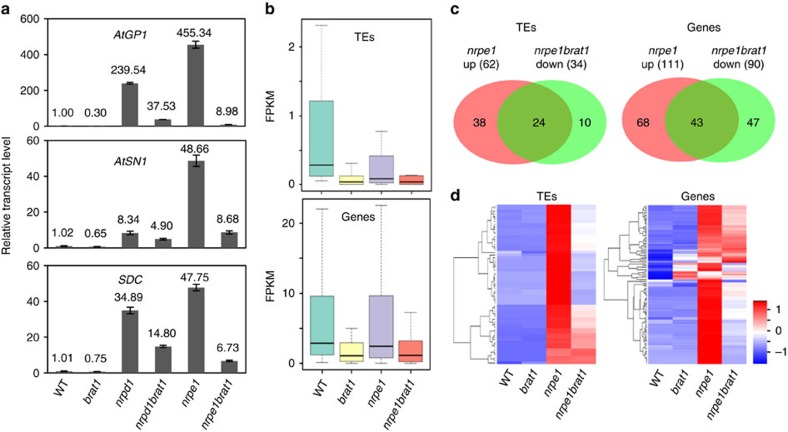
BRAT1 contributes to the expression of RdDM target loci in the RdDM mutants.(a) The RNA transcripts of AtGP1, AtSN1 and SDC were detected by quantitative RT–PCR in the indicated genotypes. Error bars are s.d. of three technical replicates in a representative experiment. (b) Box plots showing the expression of TEs and protein-coding genes that are downregulated in brat1. FPKM, fragments per kilo base of exons per million fragments mapped. (c) Venn diagrams of overlap between upregulated loci in nrpe1 versus wild type (WT) and downregulated loci in brat1nrpe1 versus nrpe1. (d) Heat maps showing RNA transcripts of upregulated (log2(fold-change of reads)>1, P<0.01,Cufflinks) TEs and genes in nrpe1 compared with the WT. The columns represent the indicated genotypes, and the rows represent the relative RNA transcript levels. Blue indicates low expression, and red indicates high expression.